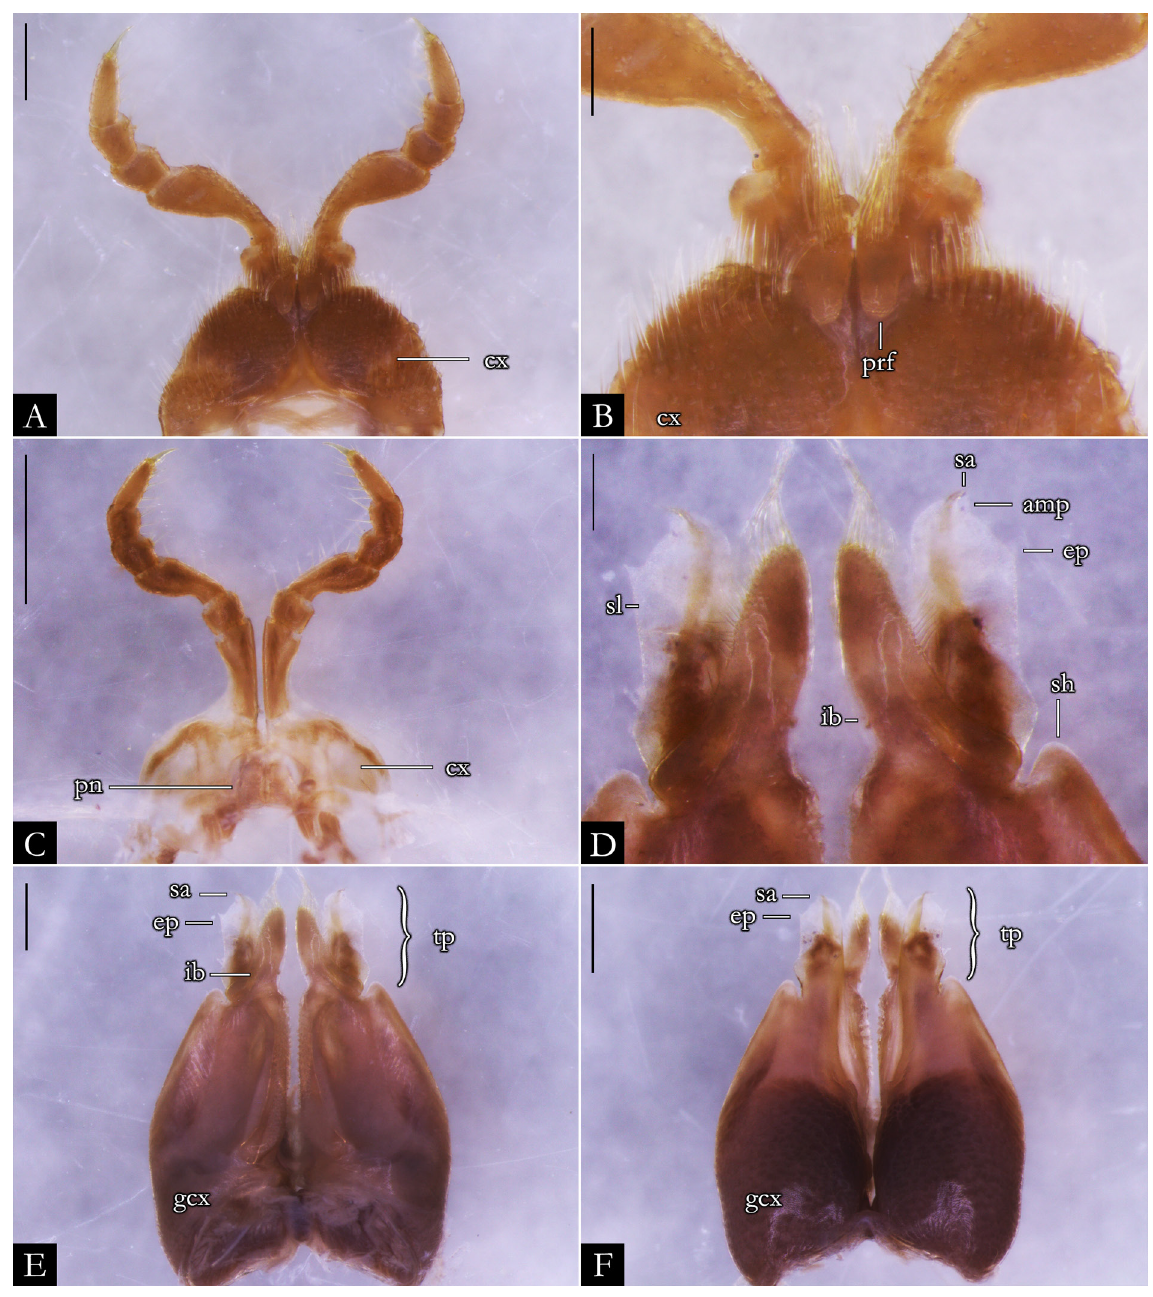
Fig. 154. Pseudonannolene granulata sp. nov., paratype, ♂ (MNRJ). A . First leg-pair. B . Detail of prefemur. C . Second leg-pair. D . Detail of telopodites, in anal view. E . Gonopods, in anal view. F . Gonopods, in oral view. Abbreviations: see Material and methods. Scale bars: A, C, E–F = 0.5 mm; B, D = 0.2